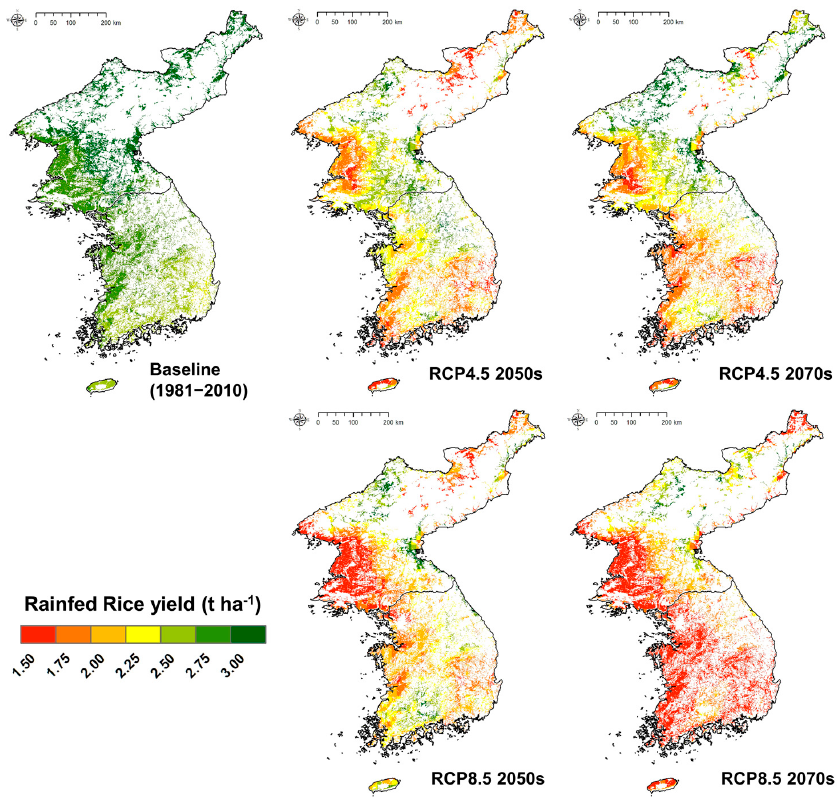
Figure 5. Rain-fed rice yields under baseline and future climate conditions in the Korean Peninsula. Table 2. Rain-fed and irrigated rice yields under baseline and future climate conditions.